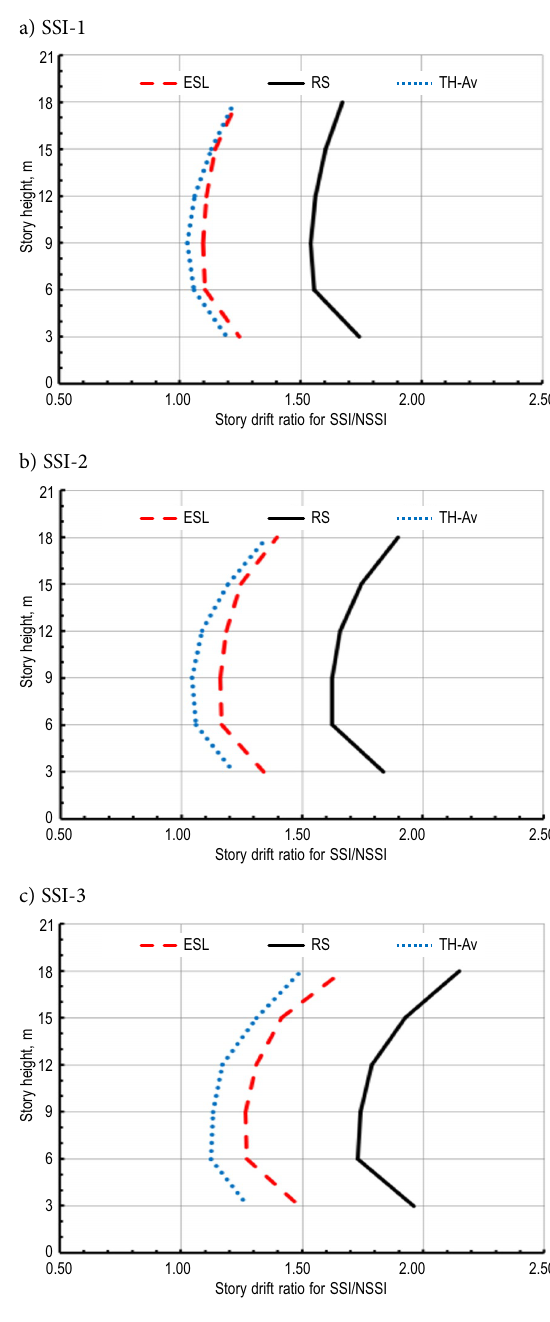
Fig. 5. Story drift ratio of SSI model to that of NSSI model of 6-story